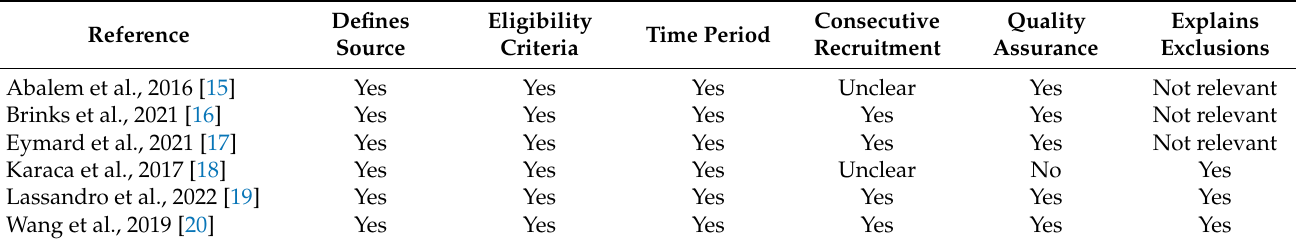
Table 4. Risk of bias within individual studies included in the review.